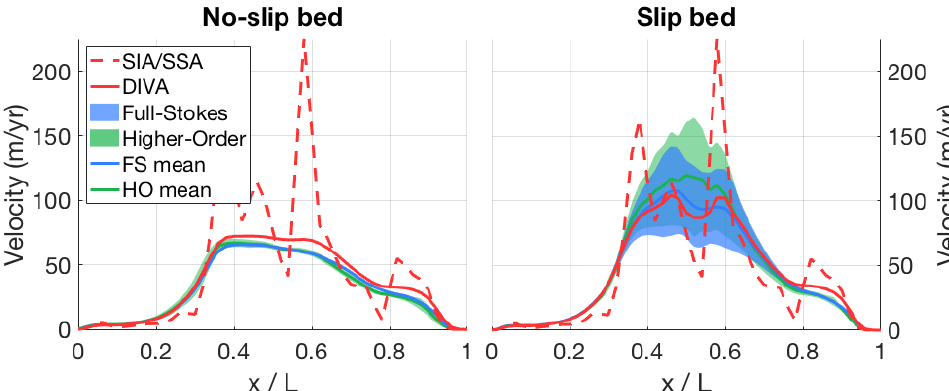
Figure B5. Modelled surface velocity transects for both versions of ISMIP-HOM experiment E (Haut Glacier d’Arolla, with and without a slippery bed region), calculated with both the old hybrid SIA/SSA solver (dashed red line) and the new DIVA solver (solid red line). The results of the higher-order models (green) and the full-Stokes models (blue) that participated in ISMIP-HOM are shown for comparison.